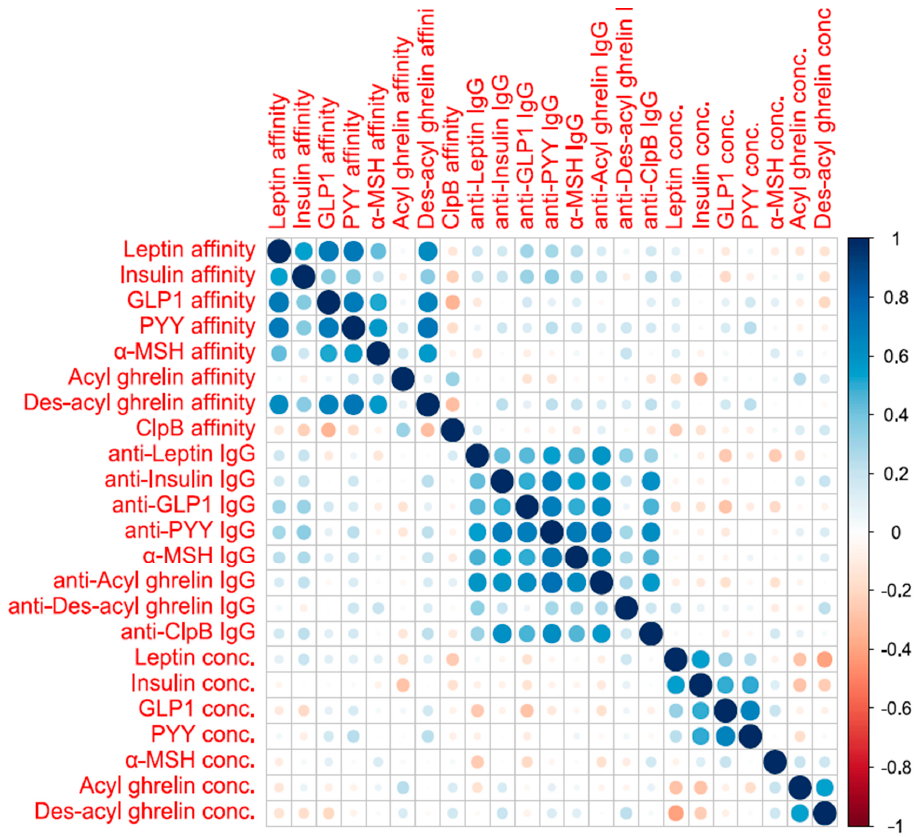
Figure 4. Correlogram representing all the correlations between the studied biological variables.